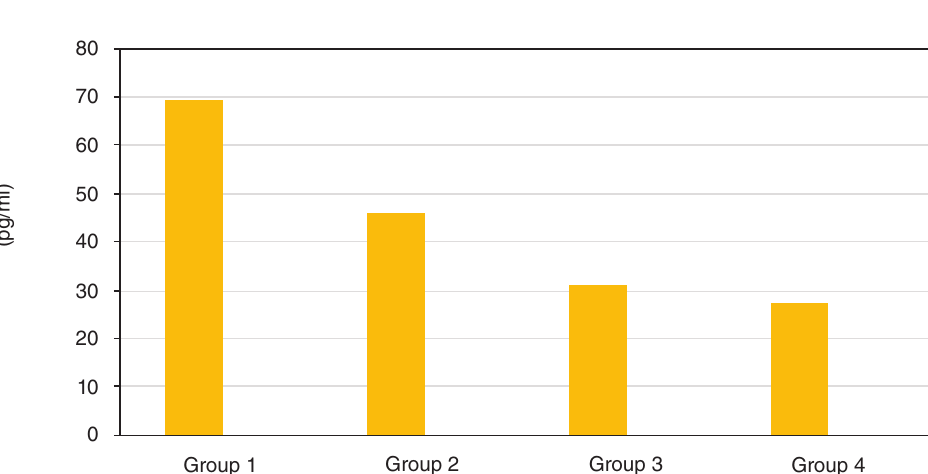
Figure 2 confirms that a significant difference is revealed in the average decrease of cortisol expression between